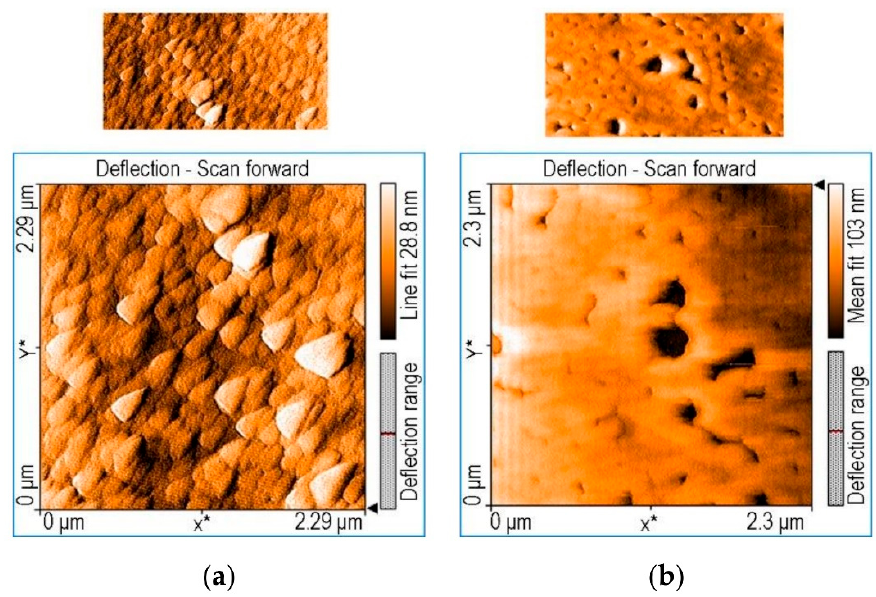
Figure 16. AFM scans illustrating significant surface coverage shown by trans 5,15-(4-carboxy-phenyl)-10,20- diphenylporphyrin ( a ) in contrast to cis configuration, 5,10-(4-carboxy-phenyl)-15,20-(4-phenoxy- phenyl)-porphyrin ( b ). Reprinted with permission from Ref. [86]. MDPI 2021.